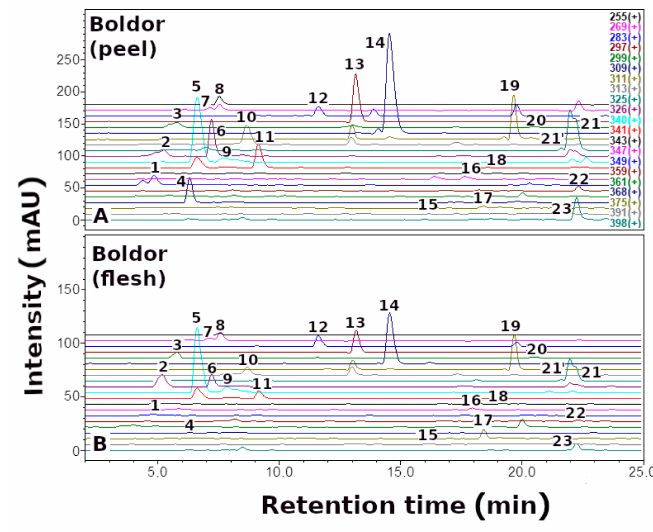
Figure 2. Selected-ion monitoring chromatogram (ESI-MS) in positive ion mode for betaxanthins of yellow Beta vulgaris L.: ( A ) peel, and ( B ) flesh. Numbers and names are available in Table 1.